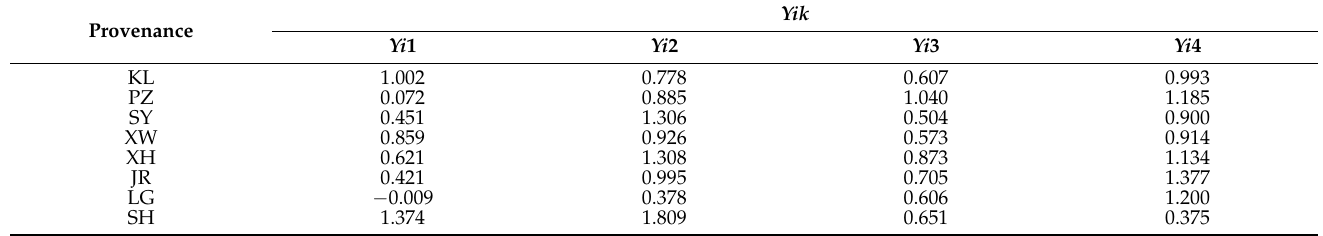
Table A6. The value of the comprehensive indexes of the different provenances under moderate drought stress.